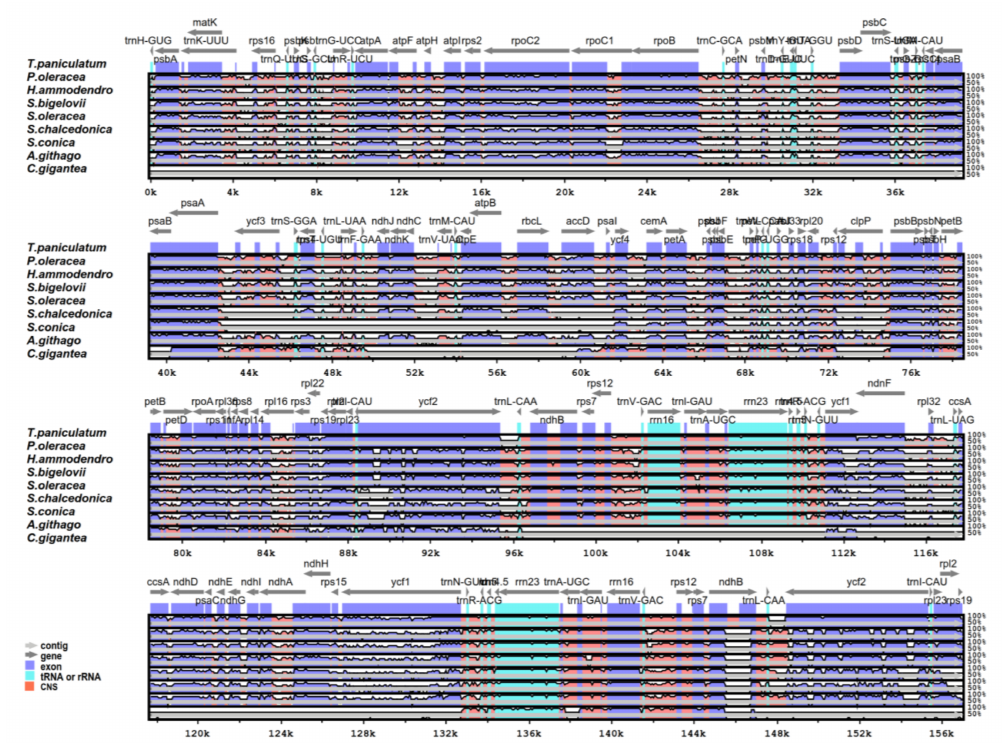
Figure 6. Complete chloroplast genome sequence comparison of eight species using mVISTA, with T. paniculatum as a reference. The horizontal axis corresponds to the coordinates within the chloroplast genome. The vertical scale represents the identity percentage. The grey lines and the arrows show the genes with their orientation and position. CNS: conserved noncoding